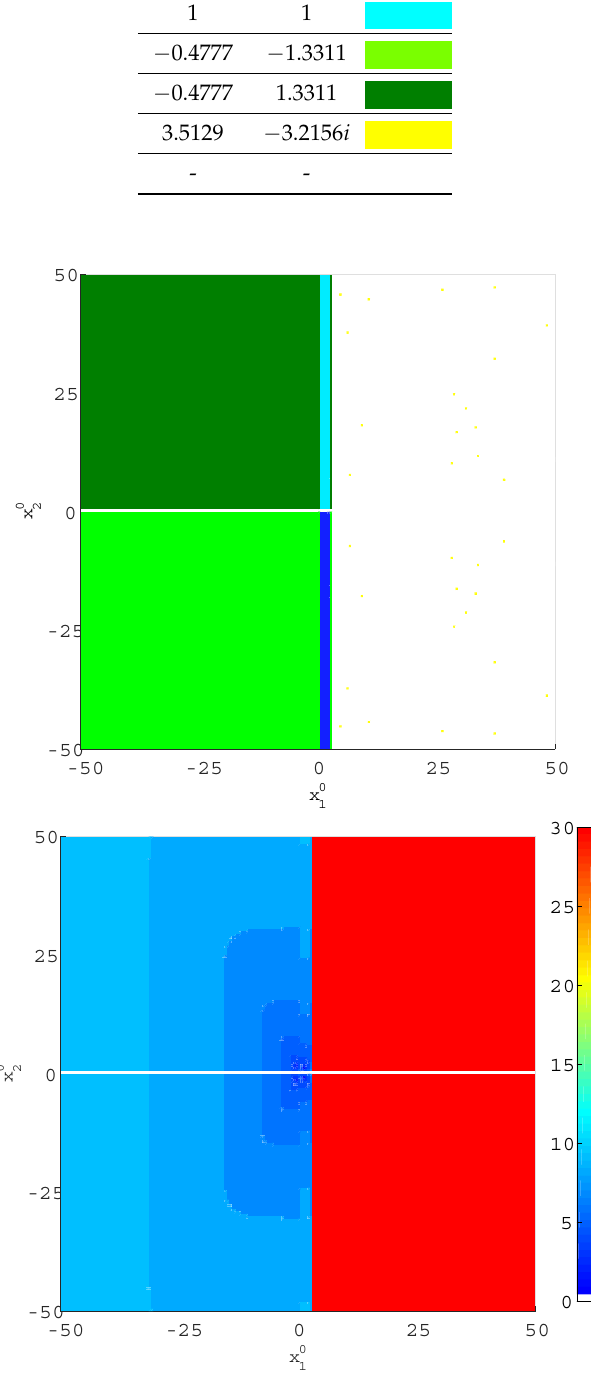
Figure 6. Basins of attraction ( upper ) and number of iterations ( lower ) for Kelley’s system when Newton’s method is